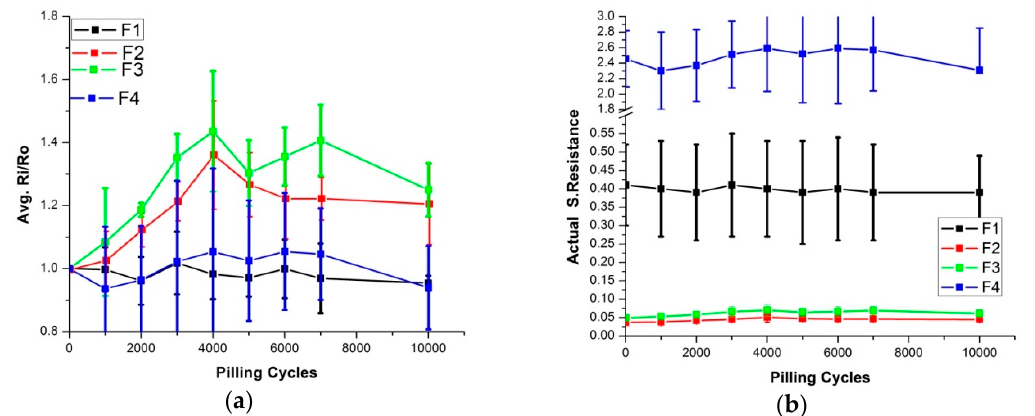
Figure 15. Surface resistance analysis after pilling cycles. ( a ) Comparison of Ri / Ro ( b ) comparison of actual resistance.